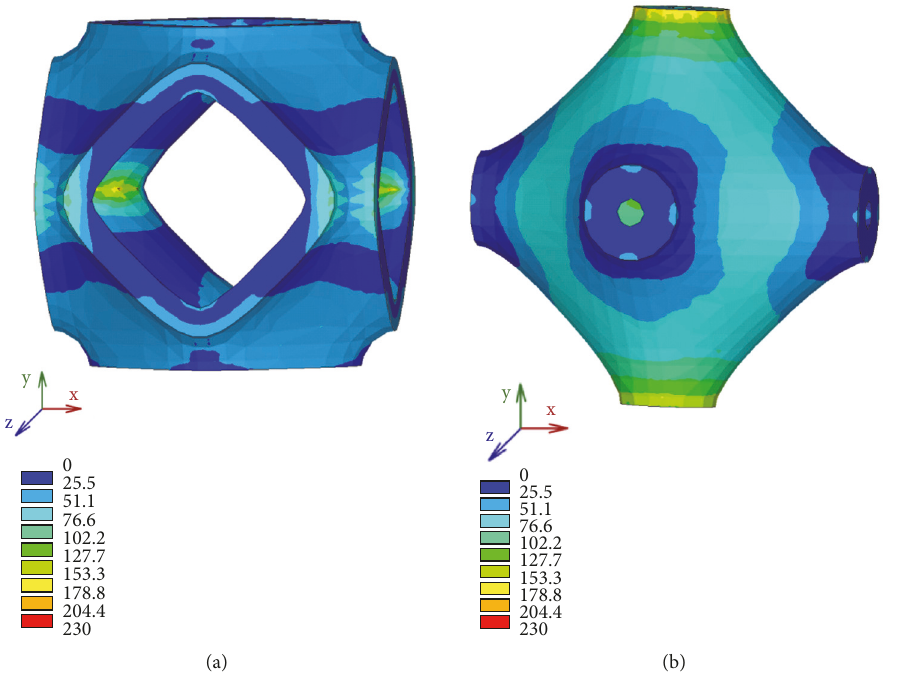
Figure 21: Von Mises stress distribution for different values of the parameter 𝑘 : (a) 𝑘 < 0 ; (b) 𝑘 > 0